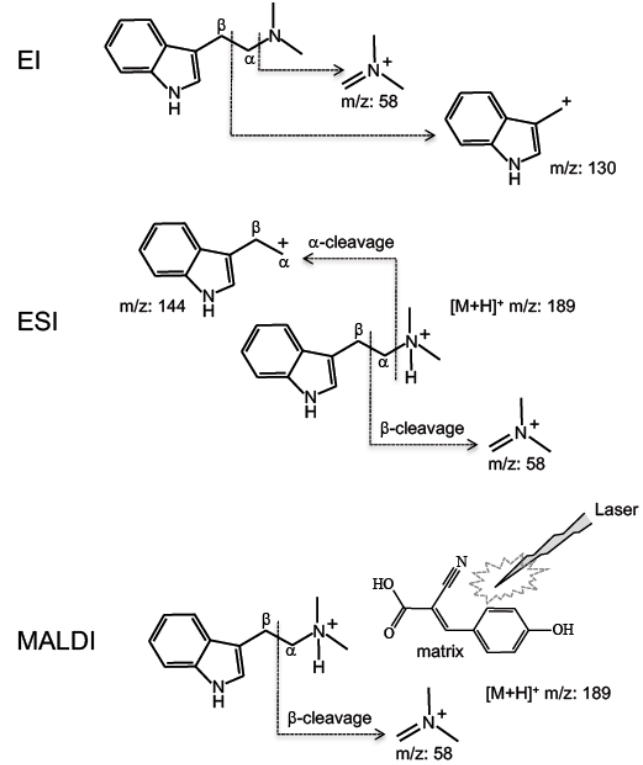
Figure 2. A general schematic outline for α -cleavage and β -cleavage when the EI/MS (electron ionization–mass spectrometry), ESI/MS (electrospray ionization/mass spectrometry) and MALDI/TOFMS (matrix assisted laser desorption/time-of-flight mass spectrometry) methods were used, respectively. N , N -dimethyltryptamine (DMT; Mw: 188) was selected as the model compound.